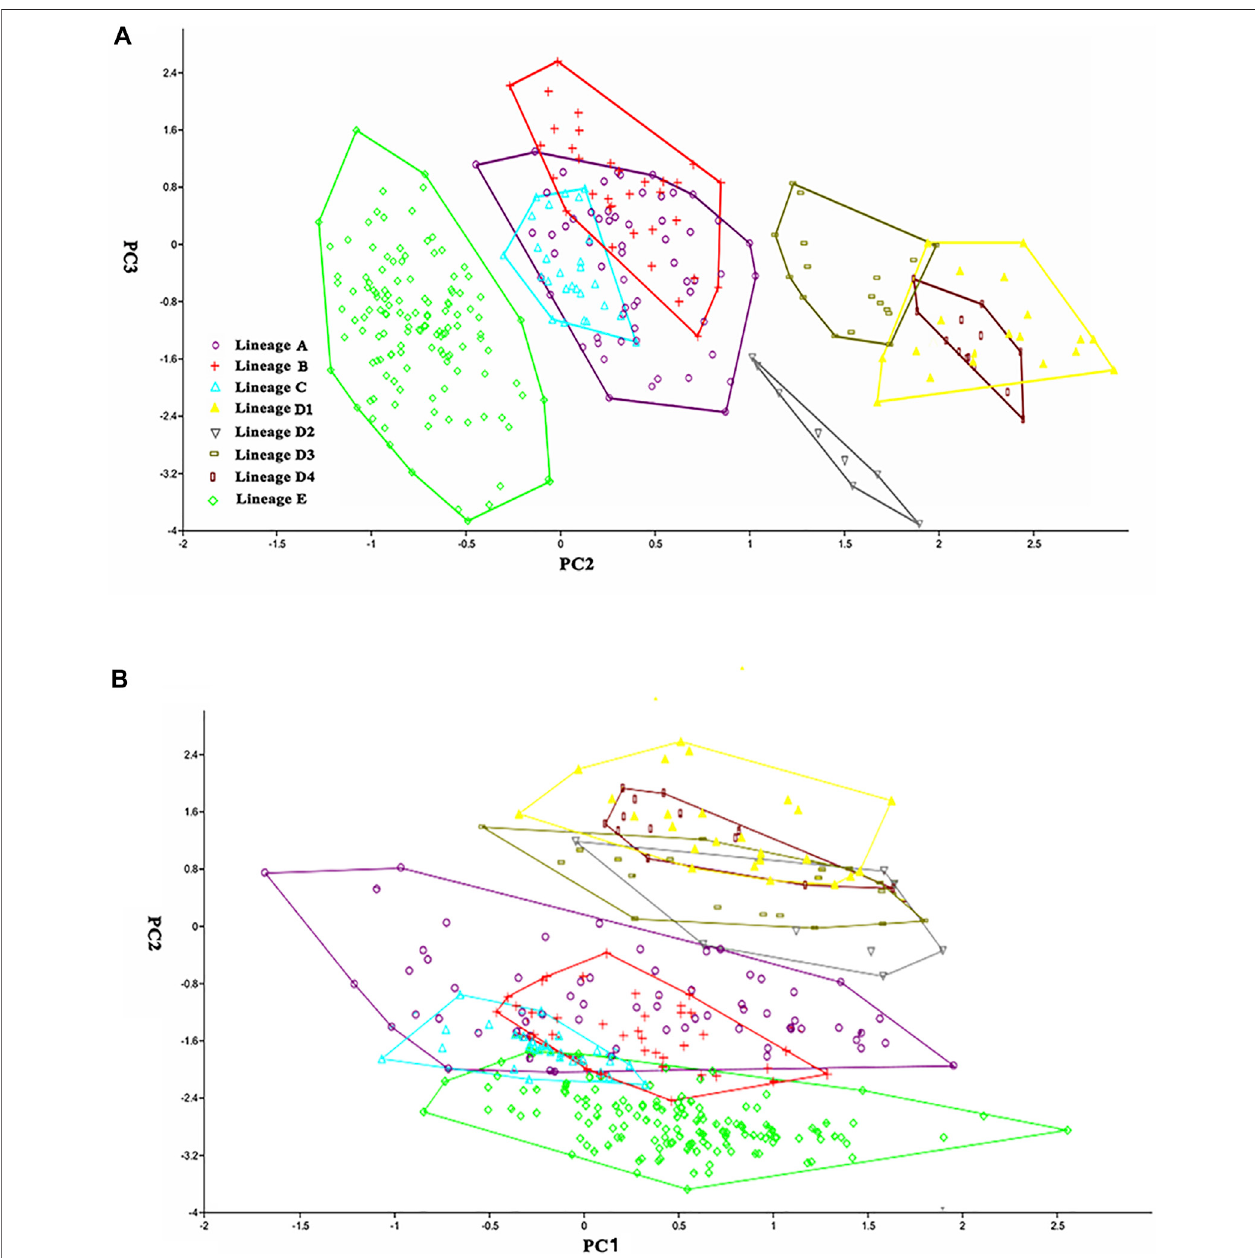
FIGURE 4 | Scatter plot of (A) PC2 against PC3 and (B) PC1 against PC2 extracted from morphometric data for eight geographic